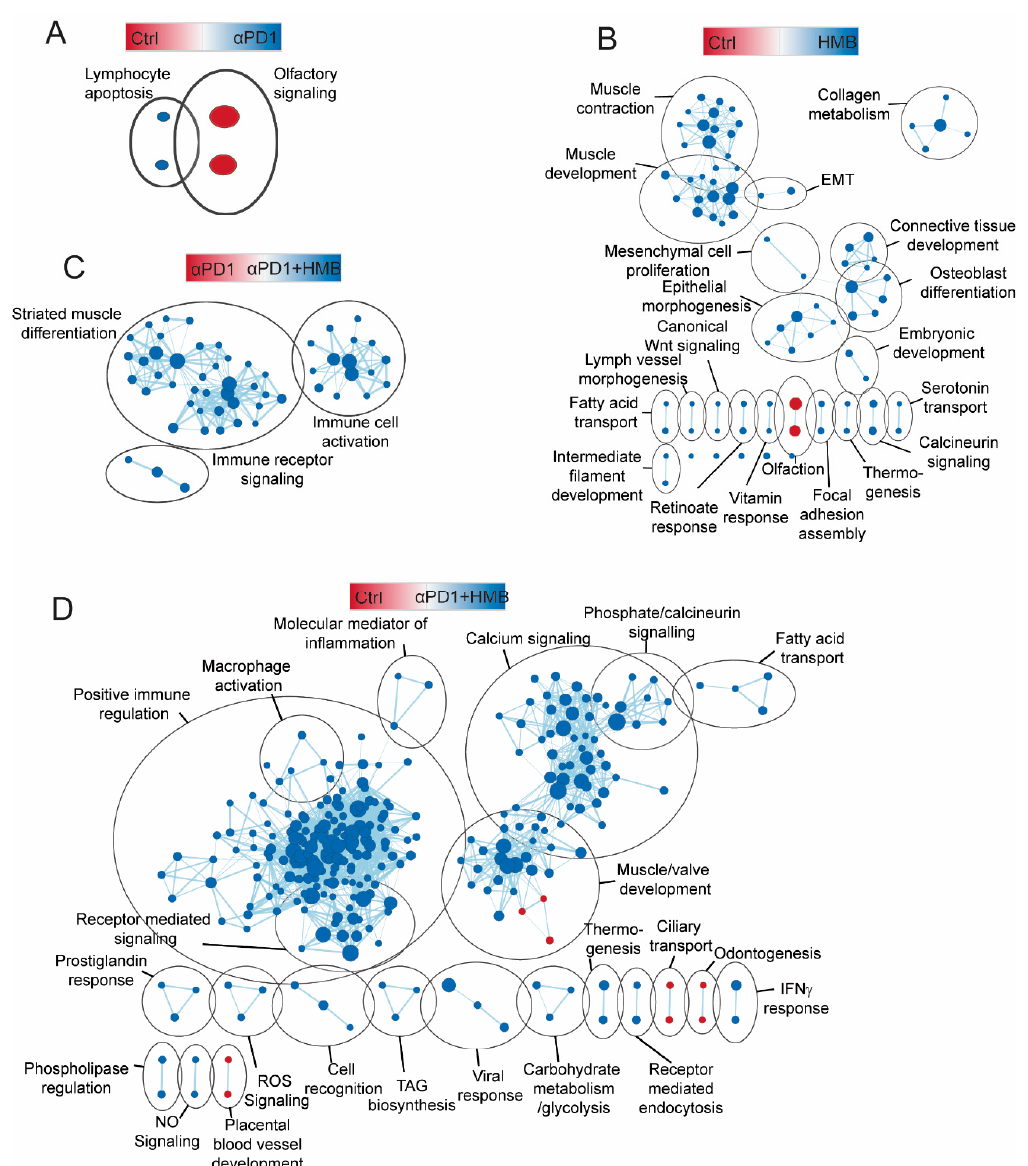
Figure 4. ( A – D ) Enrichment map of significant GSEA GO biological processes in tumors from Control and anti-PD1 treated mice supplemented with and without HMB (FDRq < 0.05). Node color indicates normalized enrichment score, node size indicates gene set size, line weight indicates degree of overlap, and clusters indicate minimum 50% overlap of gene sets. ( A ) Control vs α PD1, ( B ) Control vs HMB, ( C ) α PD1 vs α PD1 + HMB, ( D ) Control vs α PD1 + HMB ( n =